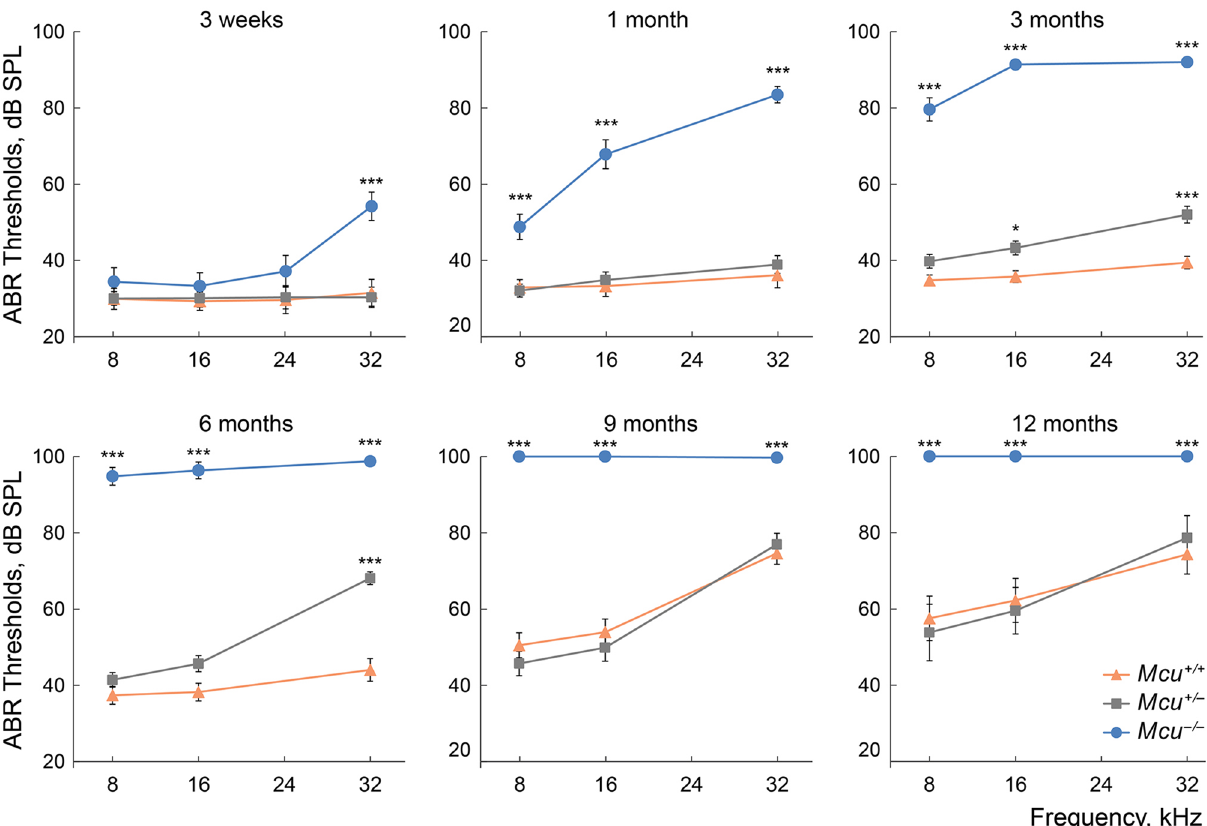
Figure 4. Hearing loss in Mcu −/− mice on FVB/NJ background. Early-onset high-frequency hearing loss rapidly progresses to profound deafness with age in FVB/NJ Mcu −/− mice. Auditory brainstem responses were recorded from the Mcu −/− , Mcu + /− , and Mcu + / + mice of FVB/NJ background, at various time points. Also, note the modest high-frequency hearing loss starting from 3 months of age in Mcu + /− mice. * p < 0.05, *** p < 0.001,